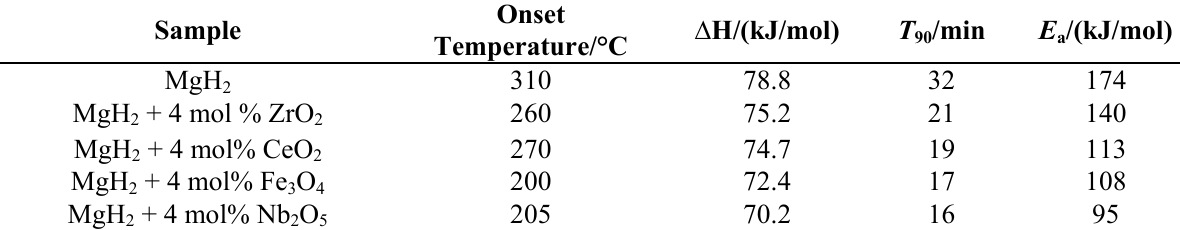
Table 1. Thermodynamic and kinetics parameters for catalyzed MgH